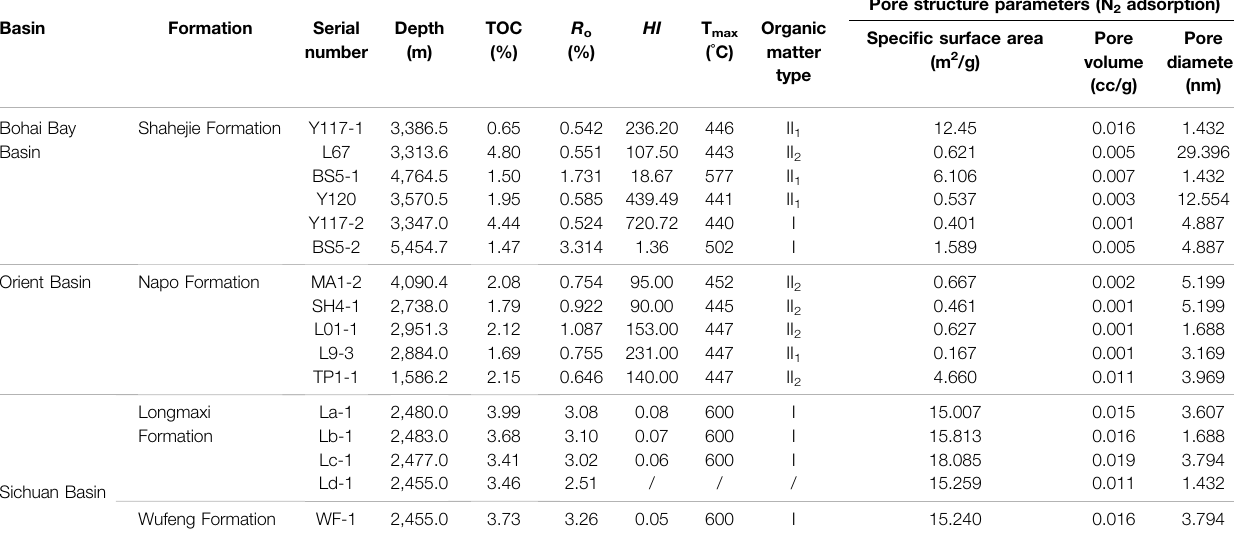
TABLE 2 | Experimental results of geochemical parameters of the shale samples in the study area.